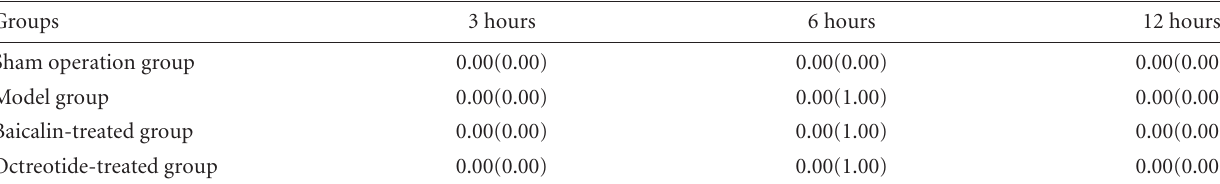
Table 8: Comparison of Bcl-2 protein expression in all groups ( M ( Q R )).